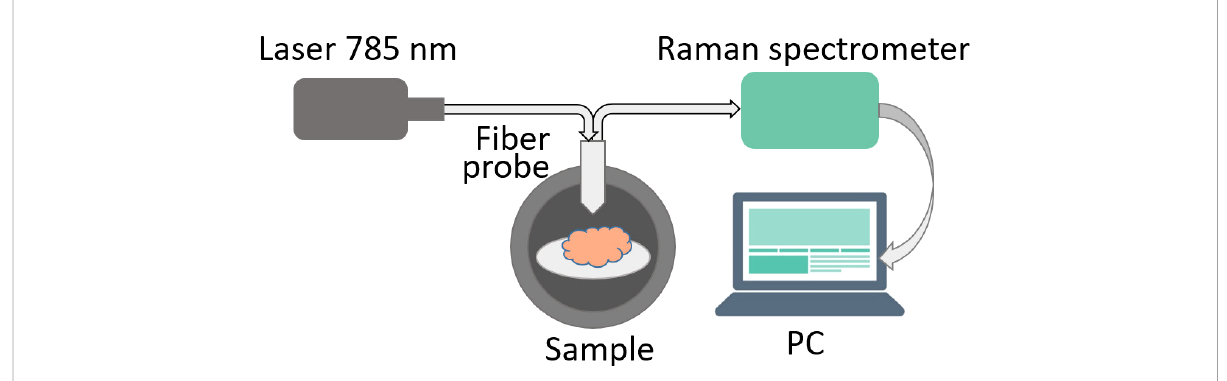
FIGURE 1 Raman spectra measurement